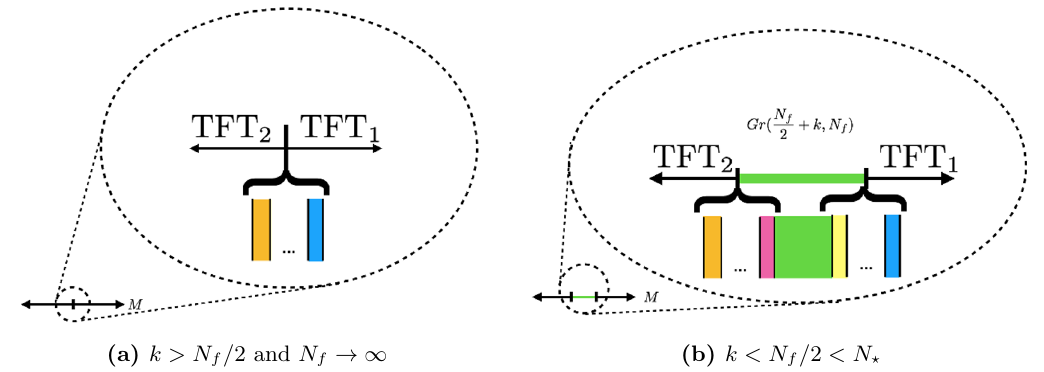
Figure 1. Resolution of critical points into a series of (cid:12)rst order phase transitions. The di(cid:11)erent colored regions represent distinct